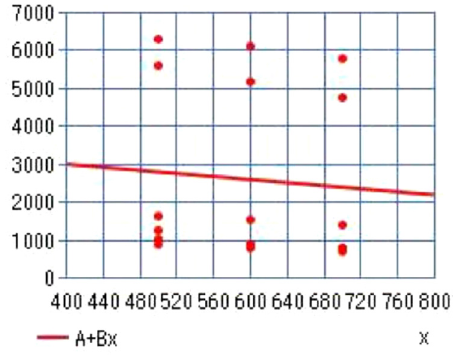
Fig. 8. X Smart Plus experimental setup.